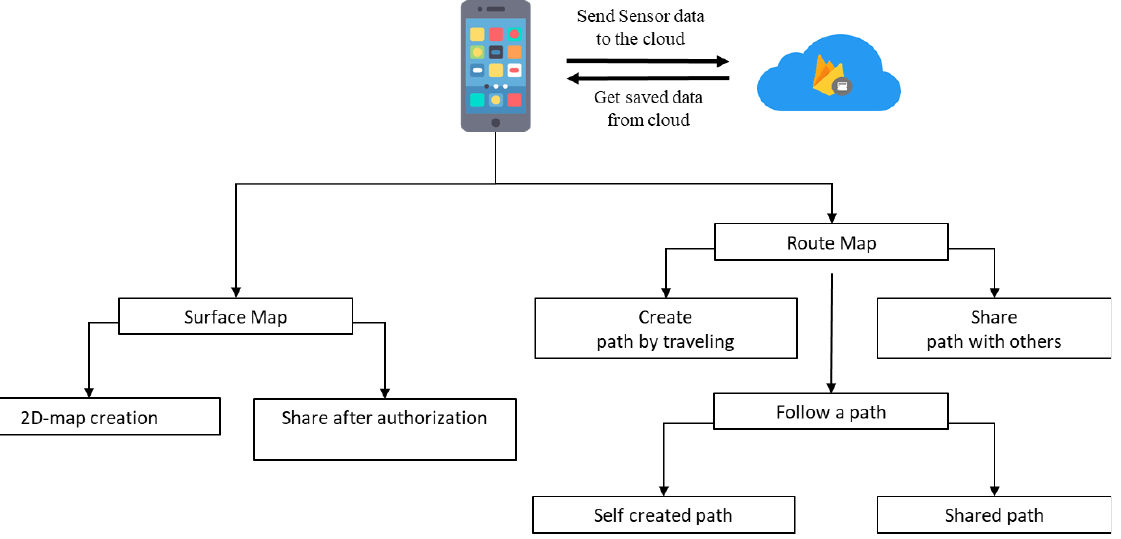
Figure 3. Key features of the smart travelling application.